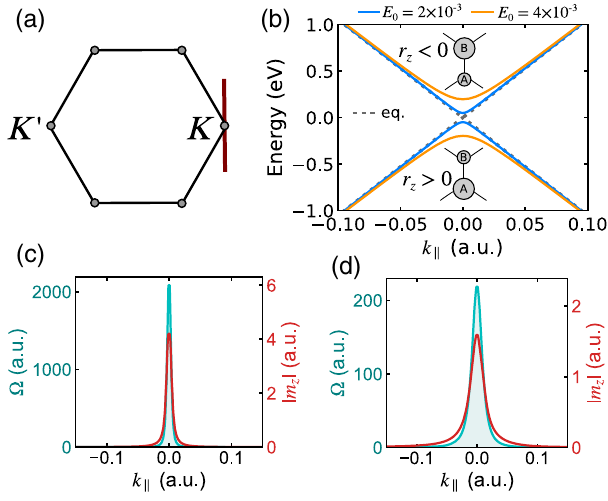
FIG. 2. (a) Path in the first Brillouin zone (BZ) close to the K point considered here. (b) Band structure of the effective ˆ k Þ compared to the equilibrium bands along h Hamiltonian eff ð the path shown in (a). The insets illustrate the orbital pseudospin. (c),(d) Berry curvature Ω ð k Þ and orbital polarization m effective lower band (calculated within second-order Brillouin- Wigner theory) for (c) E 0 ¼ 2 × 10 − 3 and (d) E 0 ¼ 4 × 10 − 3